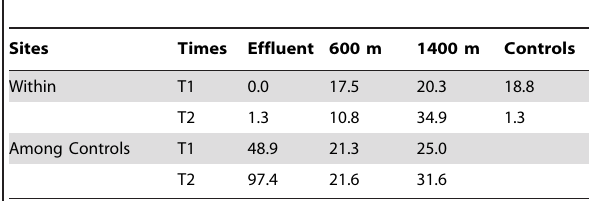
Table 5. Average Euclidean distance, considering only covers of biofilm, within the sites sampled at the discharge point (Effluent), 600 and 1400 m away from the discharge areas (600 m and 1400 m, respectively) and among control sites (C1 and C2), in each time.